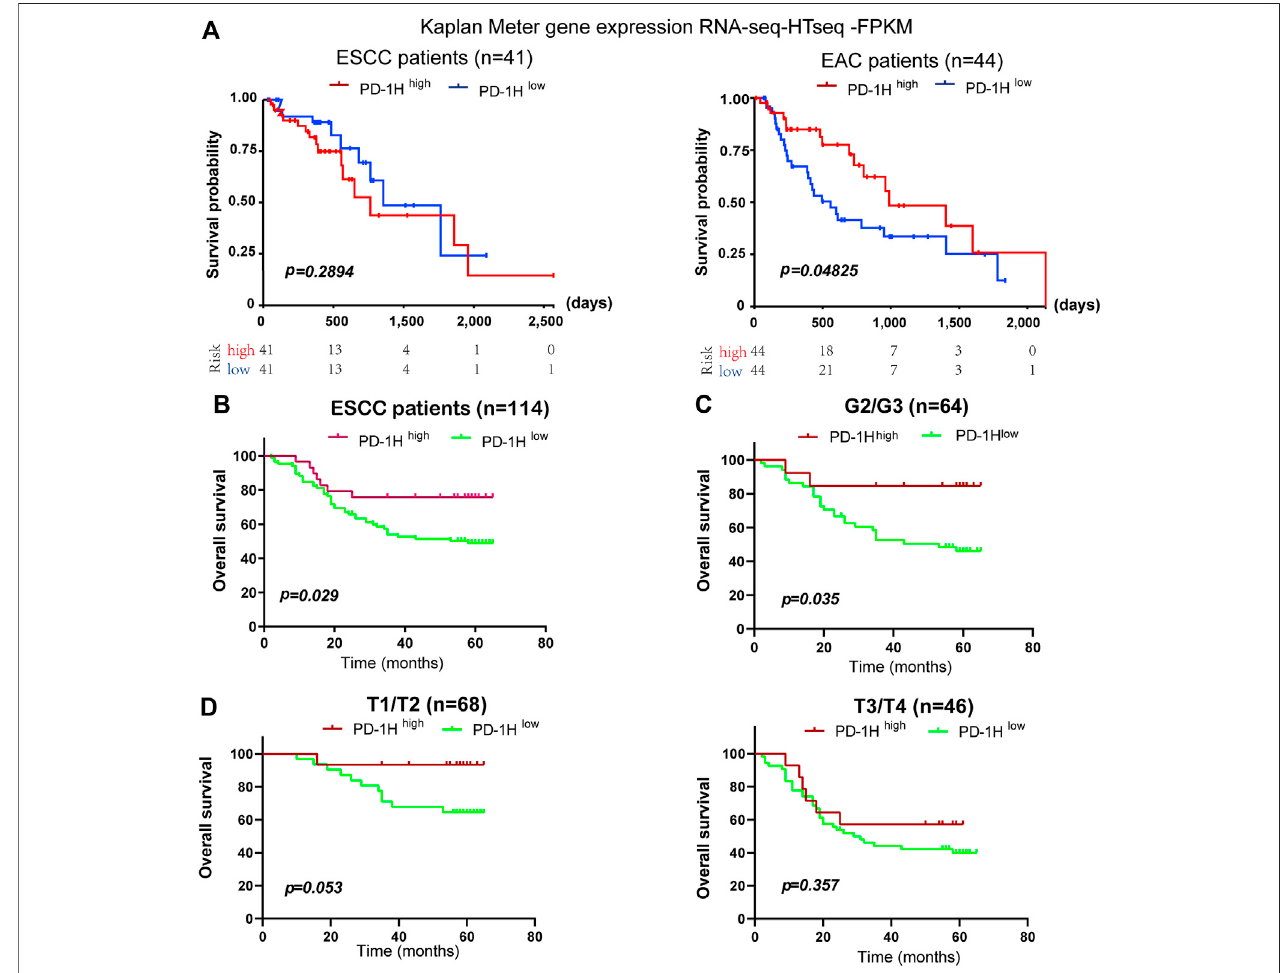
FIGURE4| Theassociation betweenPD-1Hexpression levelsand overallsurvivalinESCC. (A) The associationof PD-1H mRNA expression and overallsurvivalof patients was assessed in 41 ESCC patients and 44 EAC patients from the TCGA database. (B – D) With the applied scoring system, a score of 7.2 as the optimal cutoff point was identi fi ed by the “ survMisc ” package in R. The correlation between PD-1H protein expression and prolonged overall survival in 114 ESCC patients (B) , in the G1 and G2/3 subgroups (C) and in the T1/T2 and T3/T4 tumor stage subgroups (D) was analyzed by using log-rank (Mantel-Cox) test in GraphPad 8.0. ESCC, esophageal squamous cell carcinoma; EAC, esophageal adenocarcinoma; G (G2/G3), Grades of differentiation; T (T1/T2, T3/T4), Tumor stage.